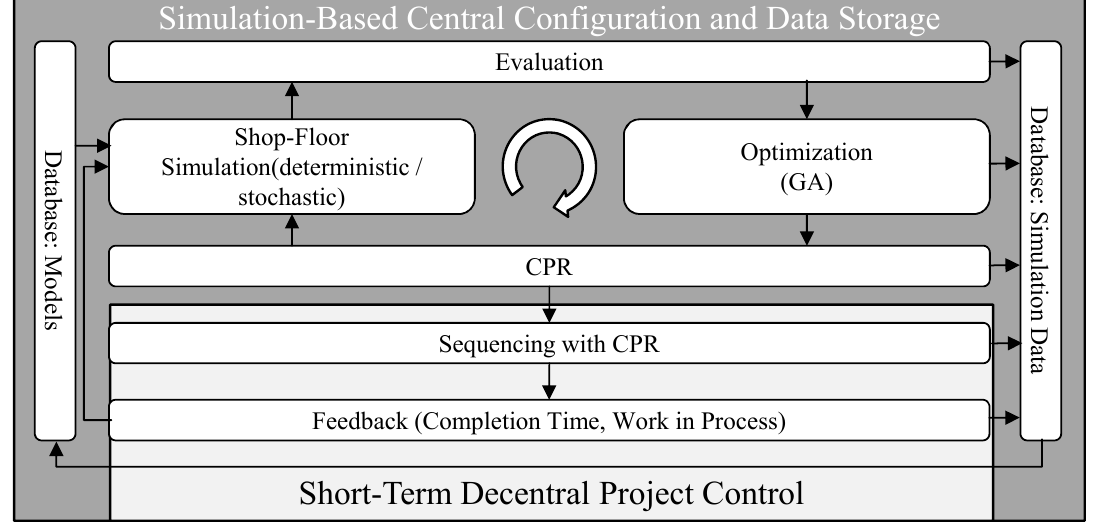
Figure 4. Concept hybrid Project Planning and Control